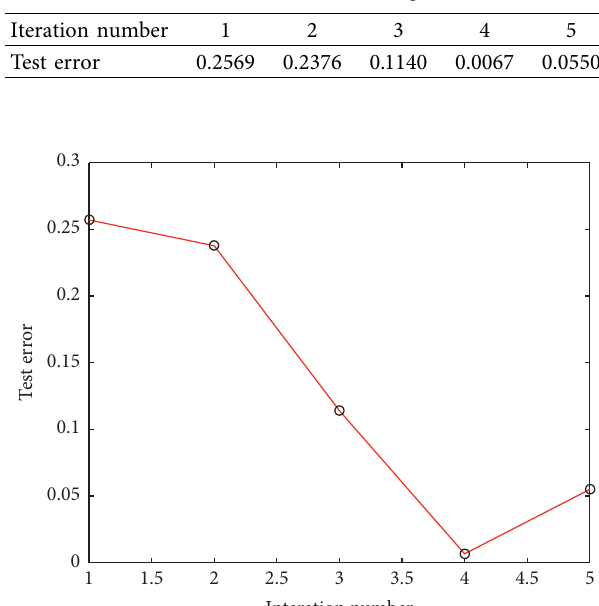
Table 7: Test error result of triangular MSA.